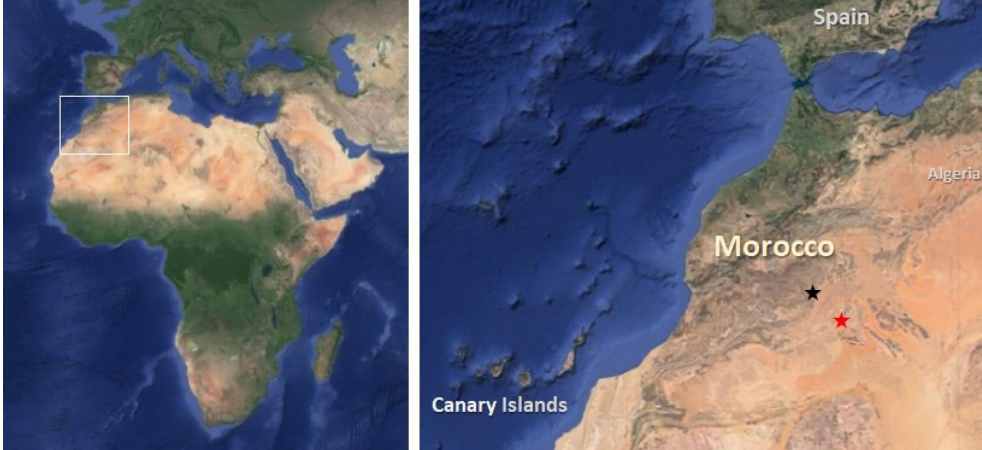
Figure 1. Geographical map with the study sites, Saada (31.63°N, 8.16°W) and Ouarzazate (30.93°N, 6.91°W) indicated with black and red stars, respectively. The picture on the left is a zoom on the study area indicated by the white box on the